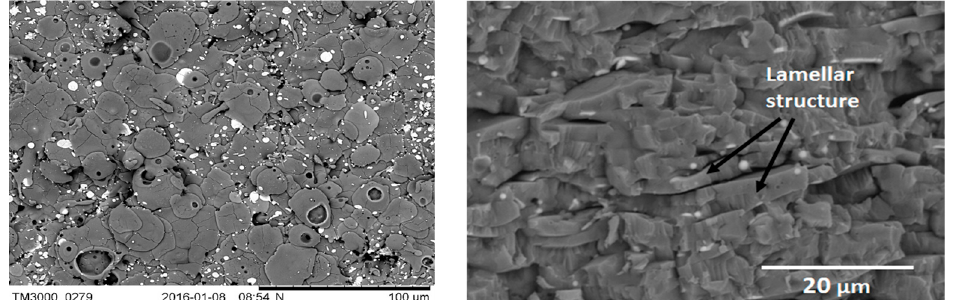
Figure 10. ( a ) Illustration of different coating architectures generated using the hybrid plasma spray setup involving feeding of conventional spray-grade powder (p) and suspension (s) feedstocks as schematically shown in ( b ) [47]. Figure 11. ( left ) Surface morphology of a typical alumina (powder)–YSZ (suspension composite coating showing multiscale structure [22] and ( right ) transverse fractured surface of the composite coating showing vertically aligned solidification feature in alumina splats with distributed YSZ (seen as the brighter phase in both micrographs) [21].